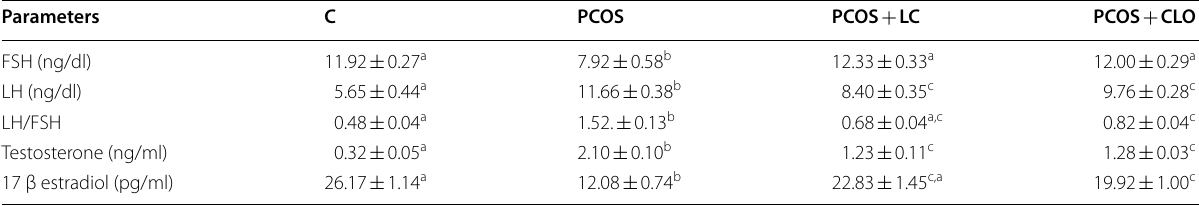
LH Luteinizing hormone, FSH Follicle stimulating hormone, C Control group, PCOS letrozole induced polycystic ovarian syndrome, PCOS polycystic ovarian syndrome treated with l -Carnitine, PCOS CLO letrozole induced polycystic ovarian syndrome treated with Clomiphene Citrate + Values presented as mean SE ( n 6). Means denoted with different superscript letters are statistically significant at P < 0.05